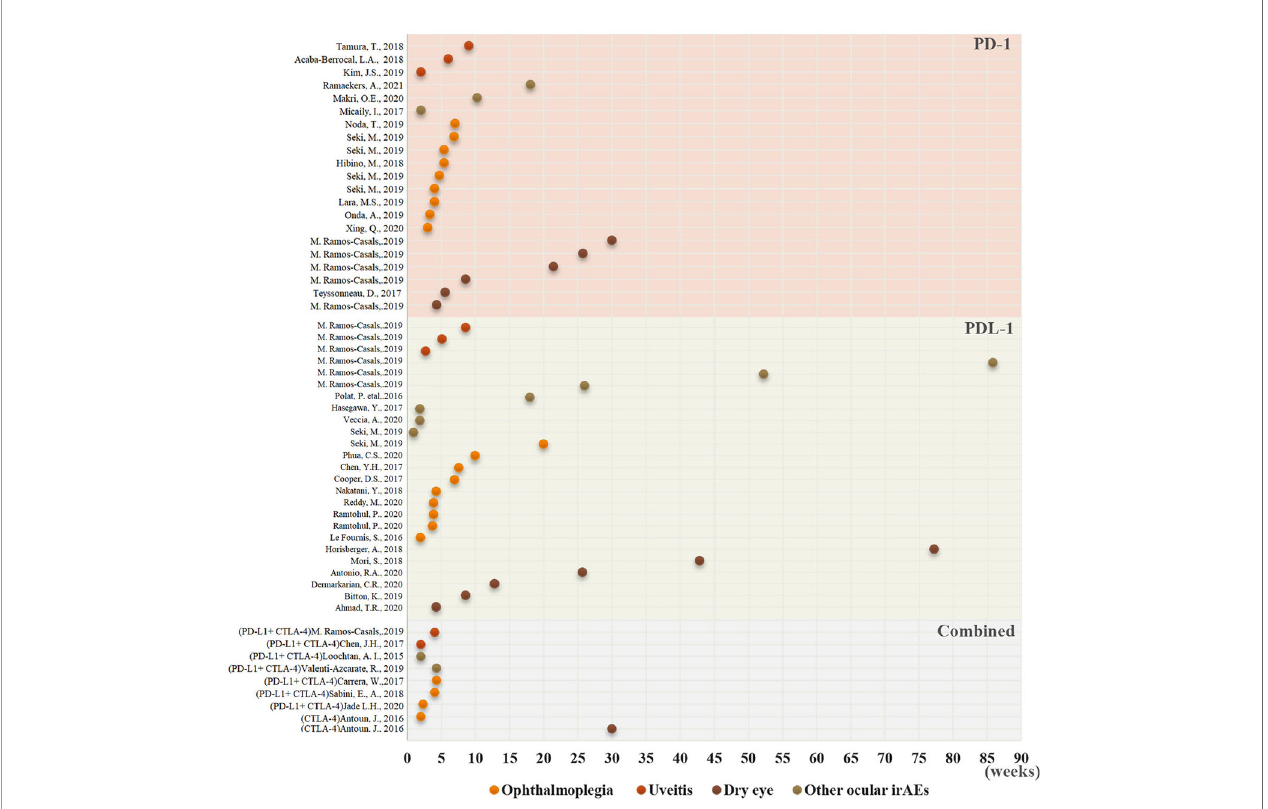
FIGURE 2 | The onset time of the distribution of different ocular irAEs in lung cancer following ICI use. The onset time of ocular irAE detection has been recorded as a dot. Yellow, ophthalmoplegia; dark yellow, uveitis; brown, dry eye; and darkgray, other ocular